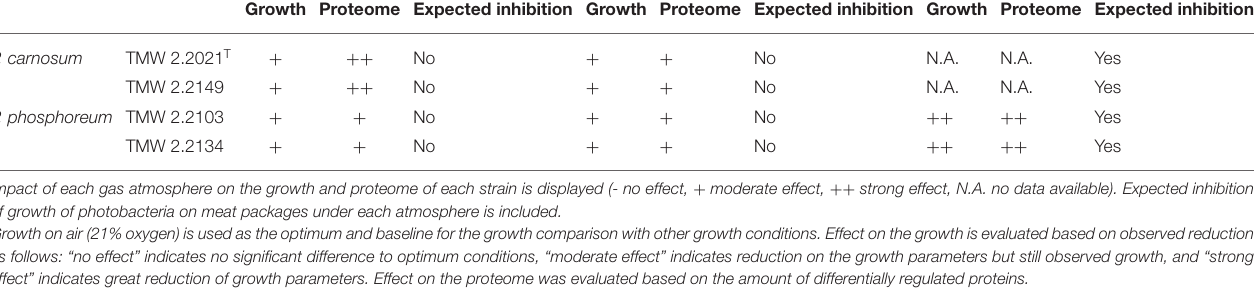
TABLE 3 | Summary of the predicted effect of the packaging atmosphere on the growth of photobacteria. Vacuum MAP (no oxygen): white meat MAP (high oxygen, 70%): red meat Growth Proteome Expected inhibition Growth Proteome Expected inhibition Growth Proteome Expected inhibition